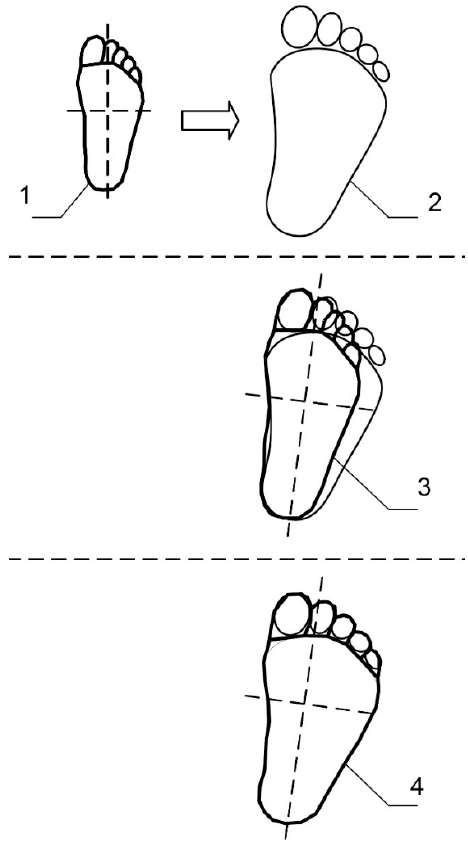
Figure 6. Localization of inspected foot template: (1) base foot template; (2) foot outline; (3) foot template transformed with rigid transformation; (4) accurate foot template transformed with non- rigid transformation.